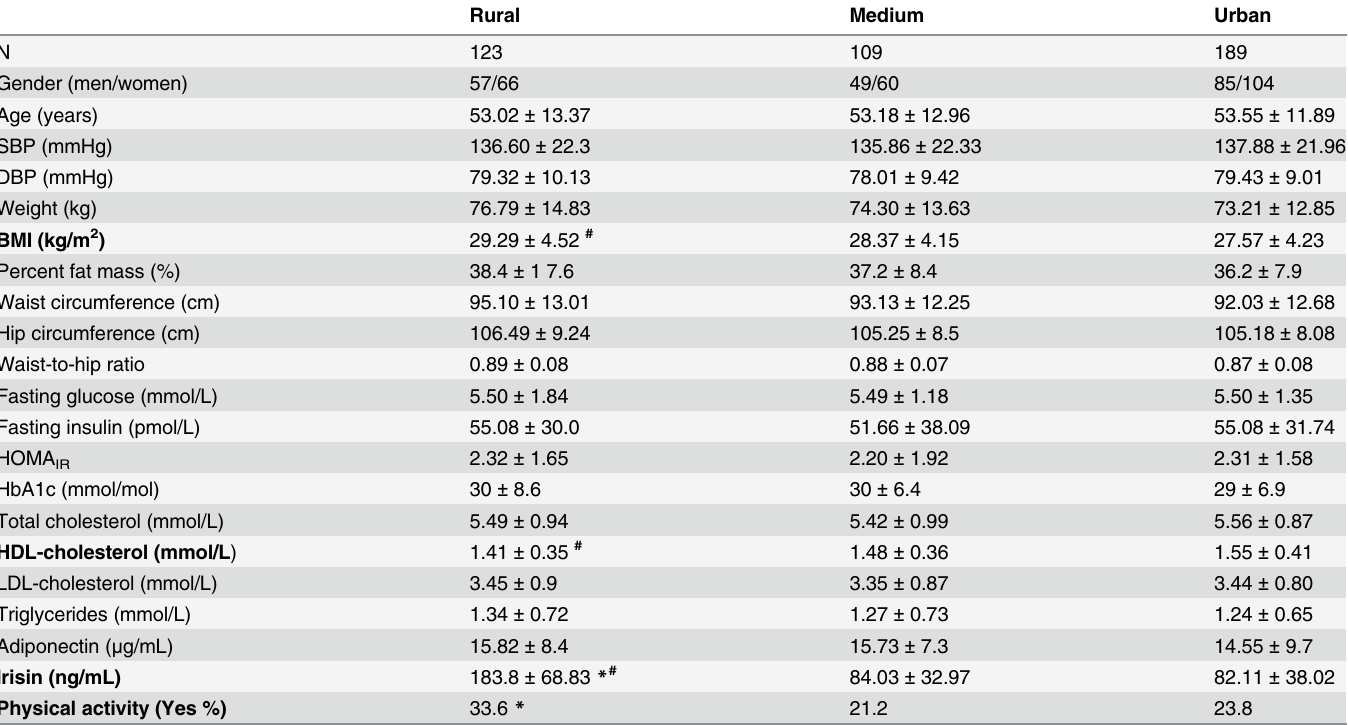
Table 1. Anthropometric and clinical parameters of study subjects according to their area of